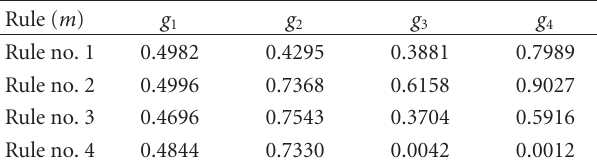
Table 11: Estimated β coe ffi cients.